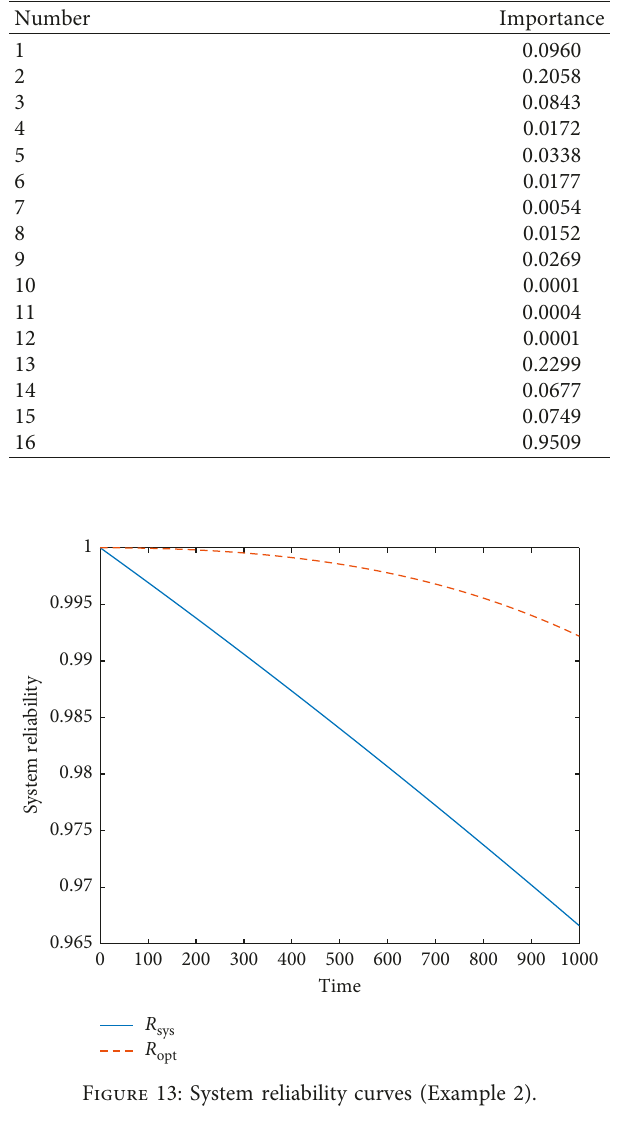
Table 13: Importance of components in Example 2.